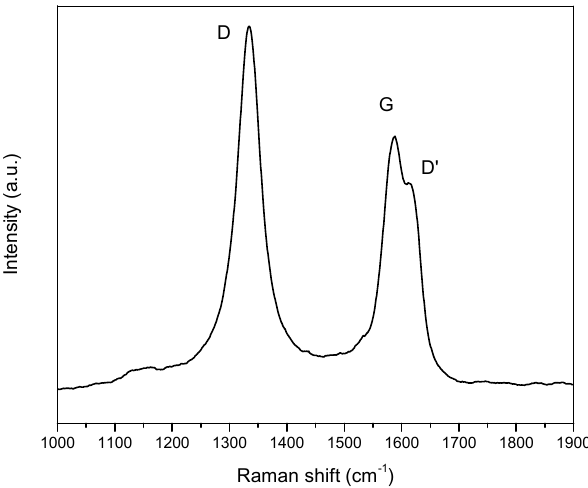
Figure 1. Raman spectrum of multi-walled carbon nanotubes (MWCNTs).